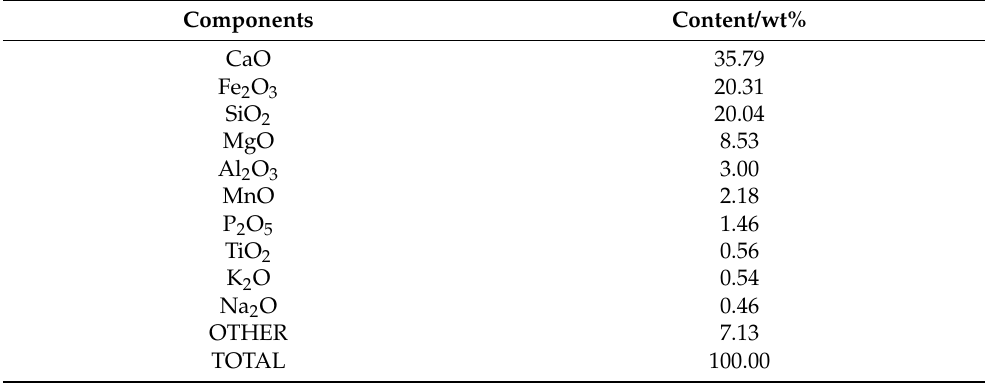
Table 4. The chemical compositions of SSA.